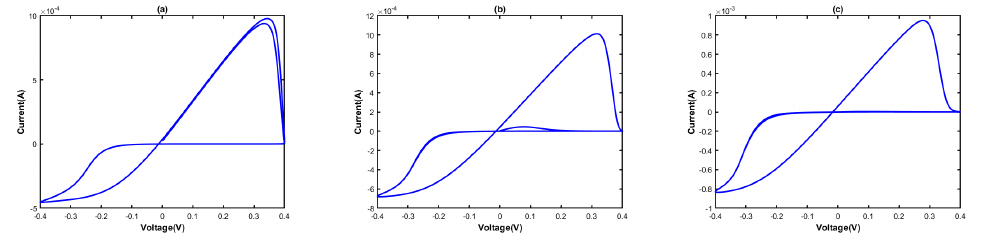
Figure 14. Hysteresis loops for different source voltages, for 45 nm: ( a ) − 0.6 V, ( b ) − 0.7 V, and ( c ) − 0.8 V.